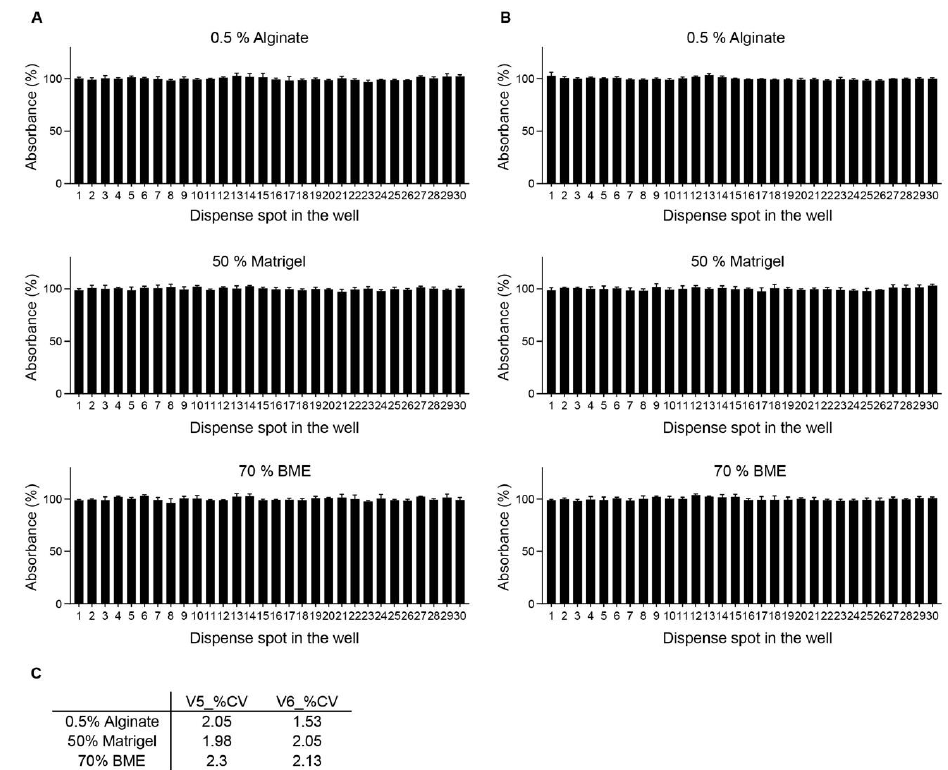
Figure 3. Dispensing accuracy and precision of ASFA SPOTTERs V5 and V6 when spotting various materials. ( A , B ) The high-viscosity biomaterials (0.5% Alginate, 50% Matrigel, and 70% BME) were dispensed into the 384-well plates with Orange G dye using ASFA SPOTTERs V5 ( A ) and V6 ( B ). The absorbance at 450 nm was measured for determination of the dispensing accuracy and precision. ( C ) The coefficient of variation (%CV) was calculated by dividing the mean absorbance by the standard deviation and then multiplying it by 100. A549 cells expressing GFP embedded in hydrogels (50% Matrigel and 70% BME) were dispensed onto the surface of a 384-pillar plate to verify the accuracy and precision of cell distribution with no clogging using ASFA SPOTTERs V5 and V6. The dispensed cells were analyzed by luminescence, cell volume was uniform, and the precision (%CV) was excellent, in that it composed less than 5% in all tested experiments (Figure 4A,B). Next, we confirmed cell growth distributed by the ASFA SPOTTER, and dispensed cells were self-assembled and proliferated to form 3D tumor spheroids (Figure 4C). This shows that the ASFA SPOTTER (V5 and V6) has advantages for dispensing cells with a high- viscosity solution and for the growth of cells in 3D with no damage.